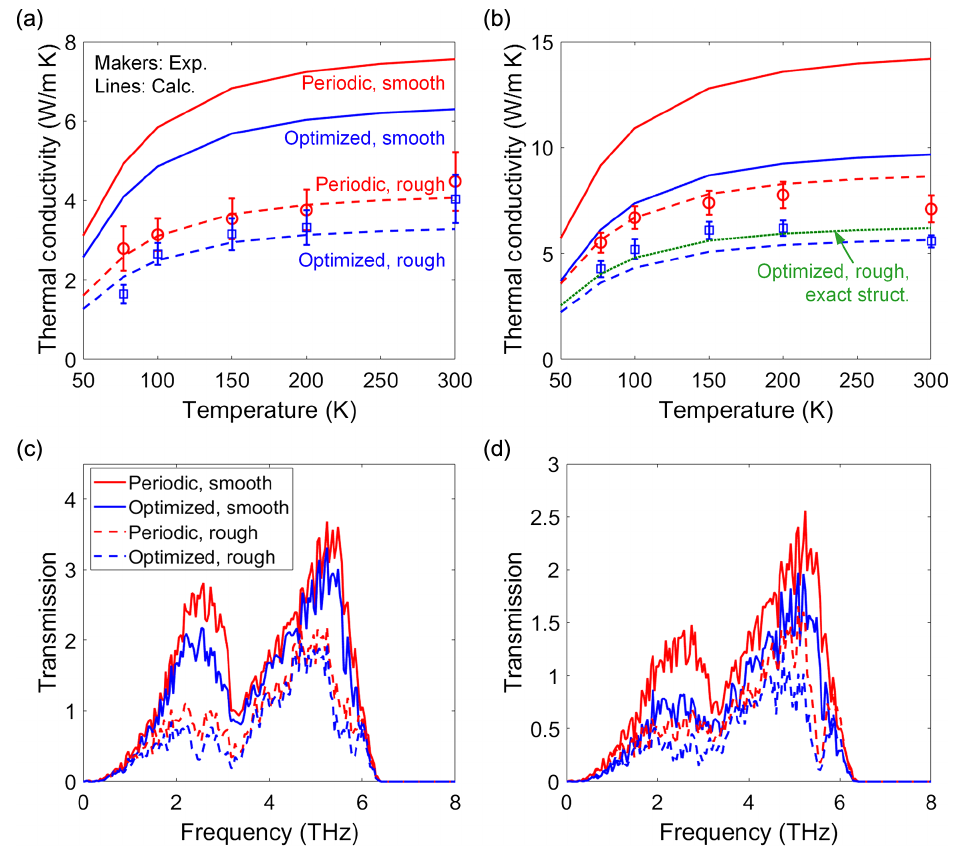
FIG. 3. Thermal conductivity and phonon transmission characterization of 16-UL and 48-UL SL structures. Experimental and calculated thermal conductivities of (a) the 16-UL and (b) 48-UL optimized aperiodic and periodic SL structures for a temperature range from 50 to 300 K. Calculated thermal conductivity of the optimized aperiodic SLs (blue) is always smaller than that of the periodic SLs (red) throughout the temperature range. Calculated thermal conductivity for rough interfaces (dashed line) is smaller than that for the smooth interfaces (solid line) and is consistent with the experimental measurements (red circles for periodic SLs, blue squares for optimized aperiodic SLs). Green dotted line in (b) denotes the calculated thermal conductivity of the exact structure of the fabricated 48- UL-SL obtained by TEM. Corresponding phonon transmission functions for the (c) 16-UL and (d) 48-UL